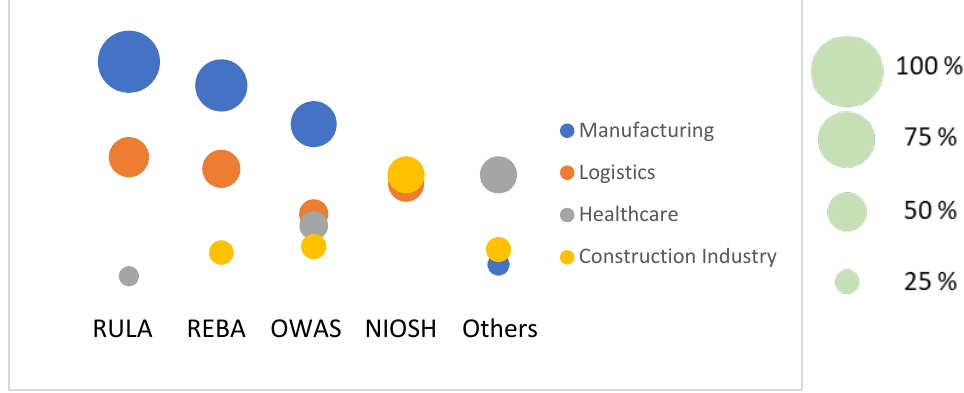
Figure 10. Graphical representation of the correlation between the ergonomic methods used and the areas in which the assessment is performed.